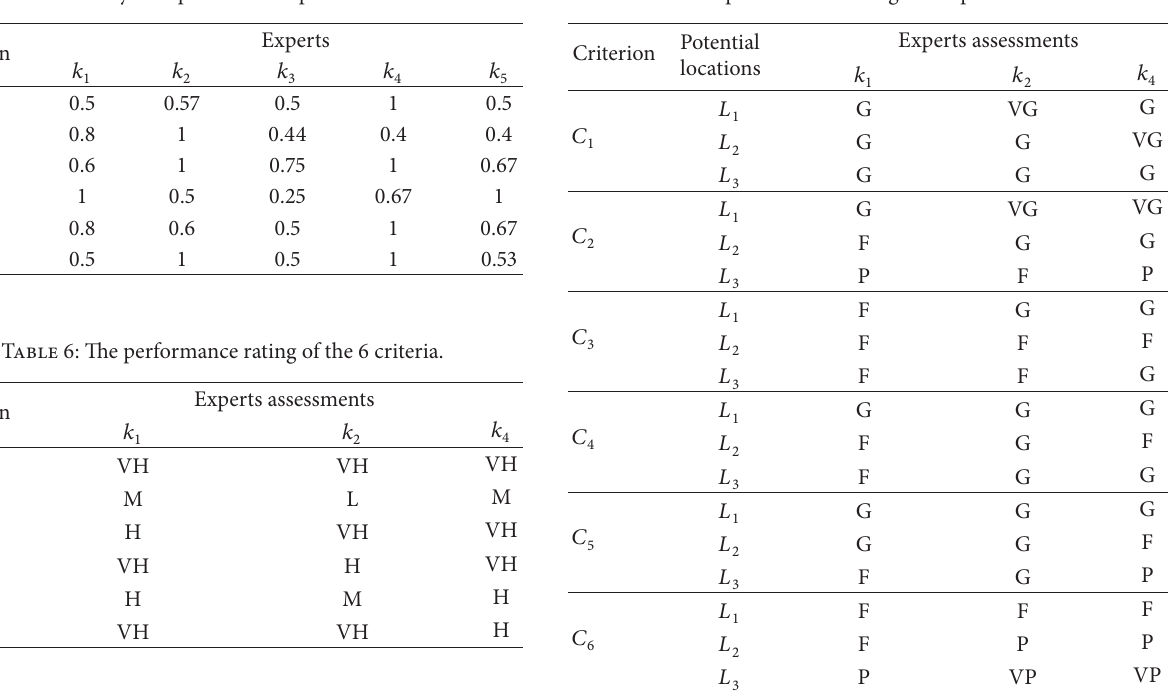
Table 5: Credibility of experts with respect to each criterion.